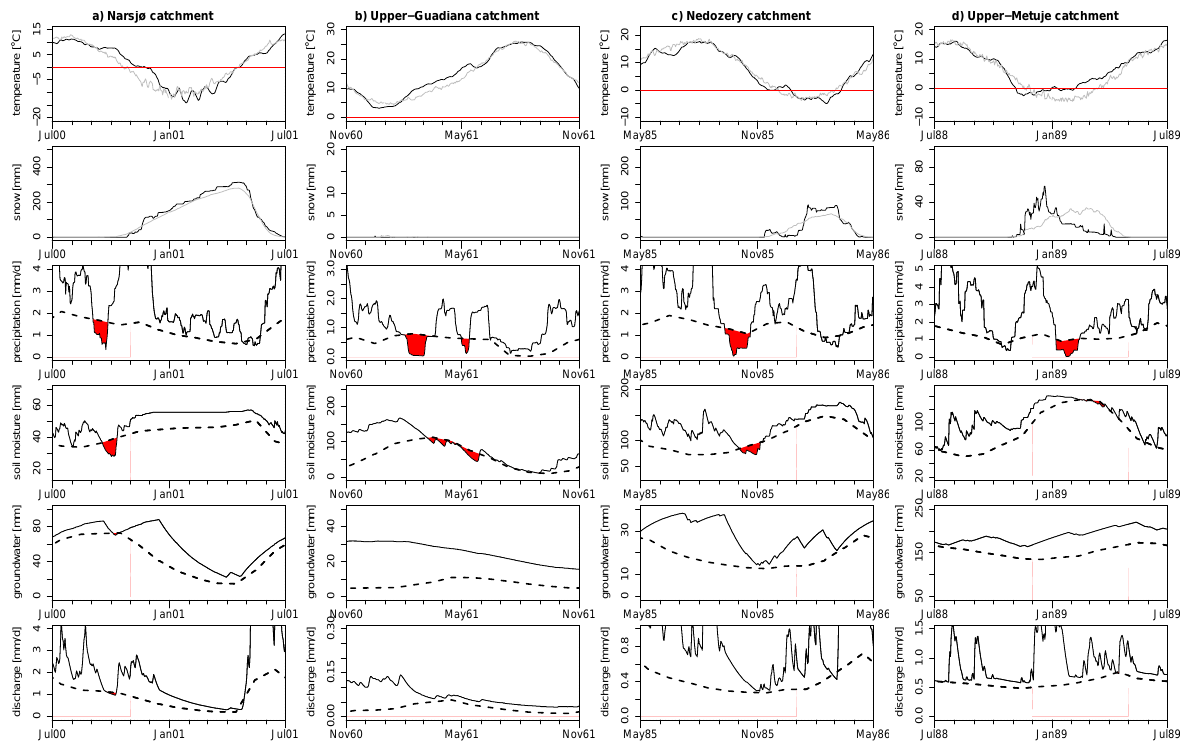
Fig. 13. Examples of non-drought events: (a) Narsjø catchment 2000–2001, (b) Upper-Guadiana catchment 1960–1961, (c) Nedoˇzery catch- ment 1985–1986, (d) Upper-Metuje catchment 1988–1989 (legend: see Fig. 5).